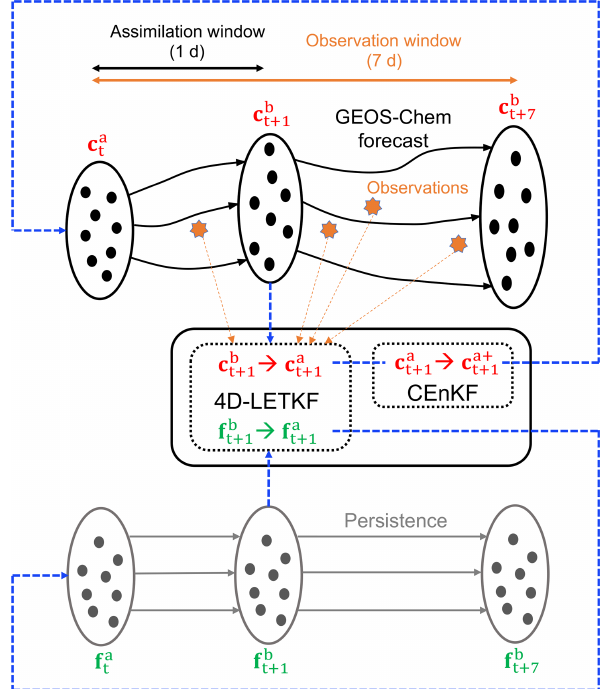
Figure 1. Flowchart of the COLA system.